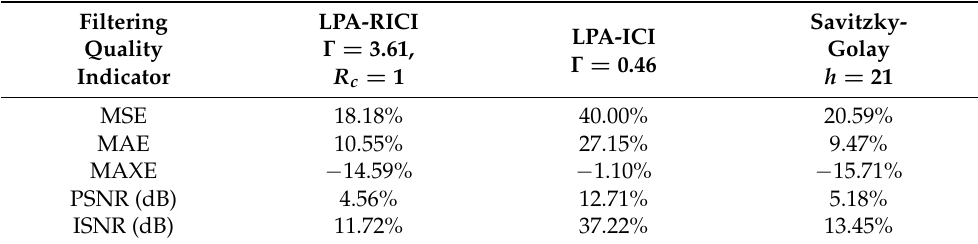
Table 19. Doppler signal (SNR = 7 dB)—Filtering quality improvement of the RBF-RICI-based filtering over other tested algorithms.